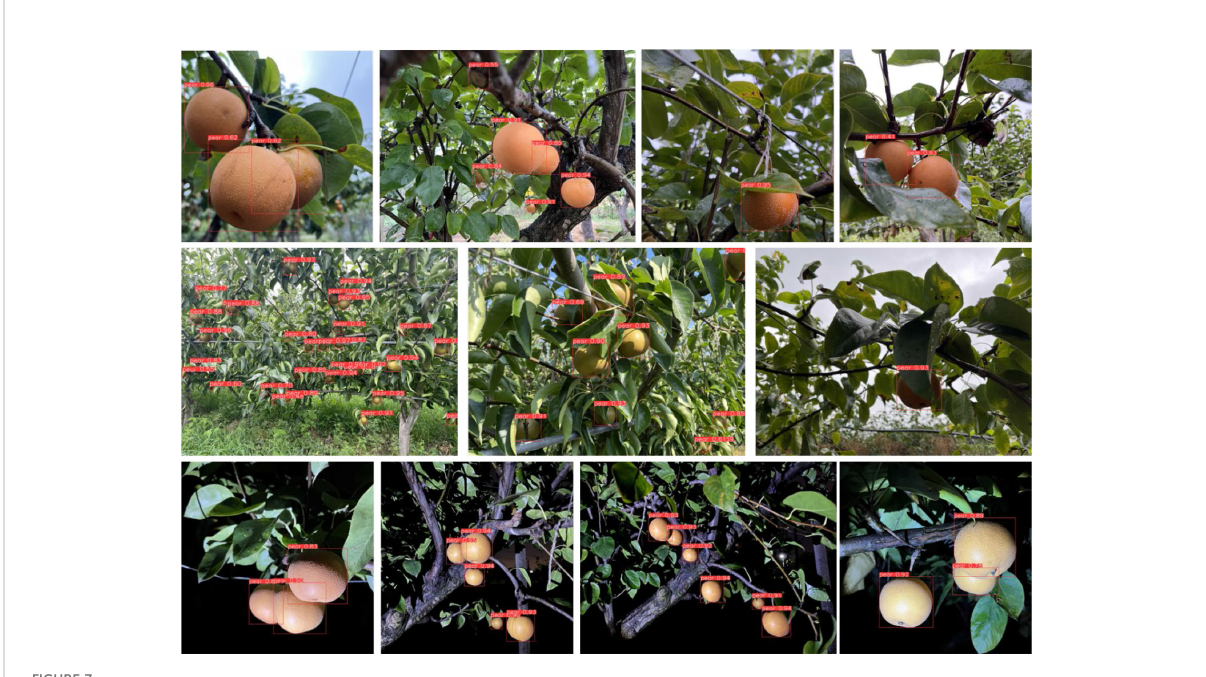
FIGURE 7 The detecting effect of Akidzuki pear in complex